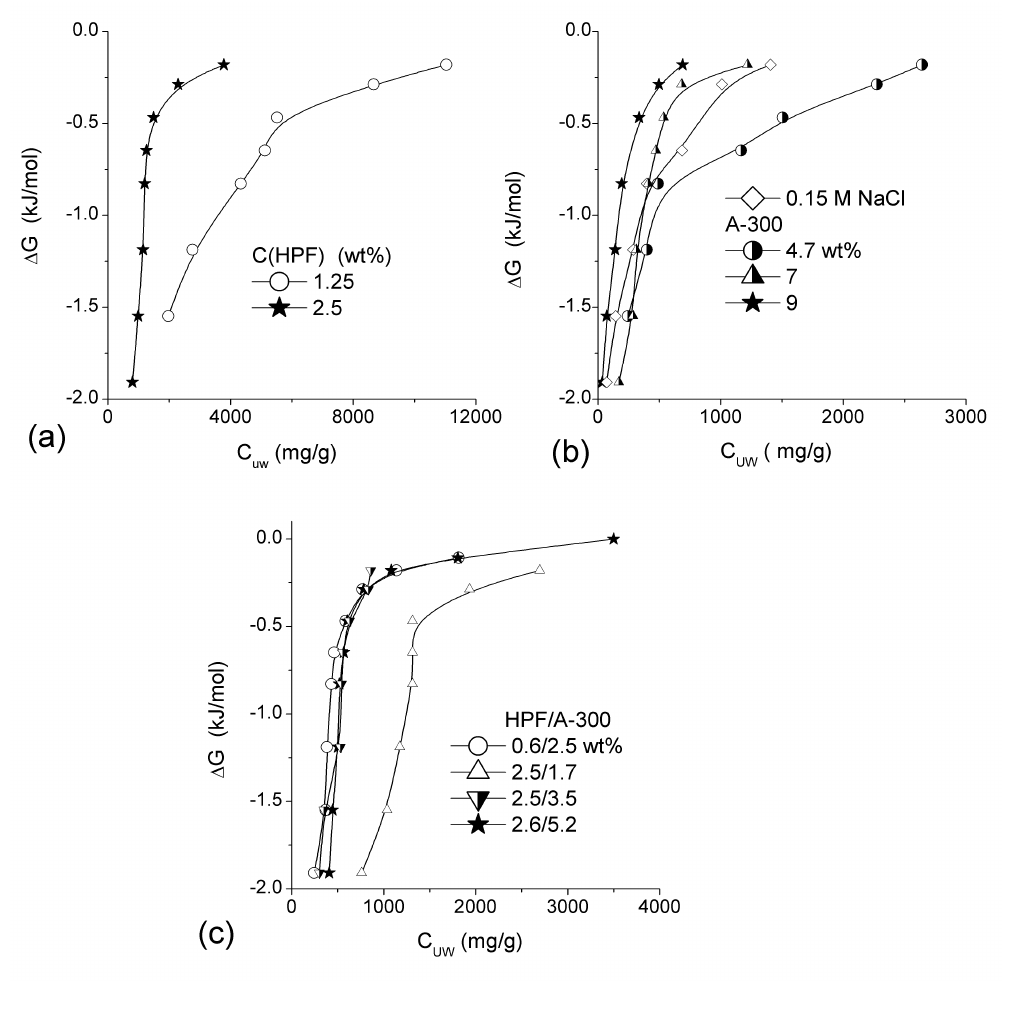
Fig. 6 Relationships between changes in the Gibbs free energy and concentration of unfrozen water for (a) HPF solution at 1.25 and 2.5 wt%, (b) 0.15 M NaCl and A-300, and (c) HPF/A-300 at different concentrations of protein and